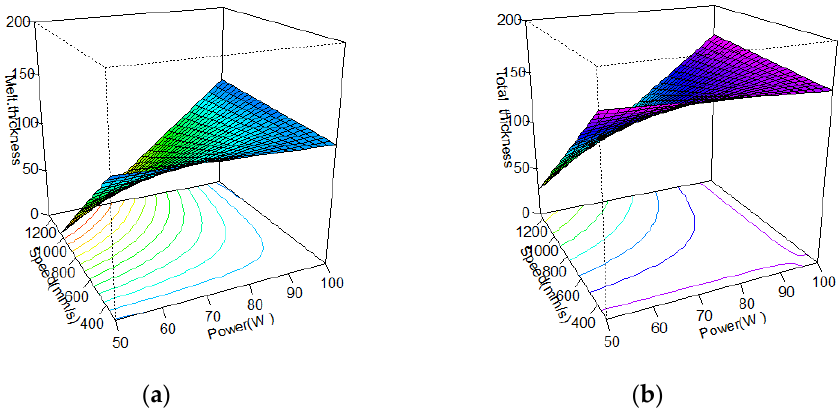
Figure 12. Central part image of thin-walled tubes built in experiment numbers ( a ) 17 (100 W/300 mm/s) and ( b ) 21 (100 W/1250 mm/s).